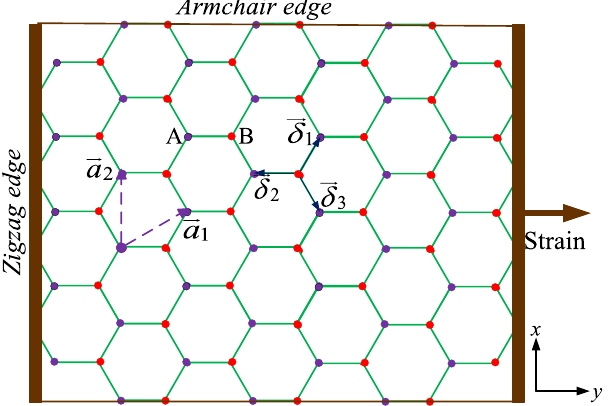
(cid:31)(cid:30) (cid:31)(cid:30) , δ , 1 2